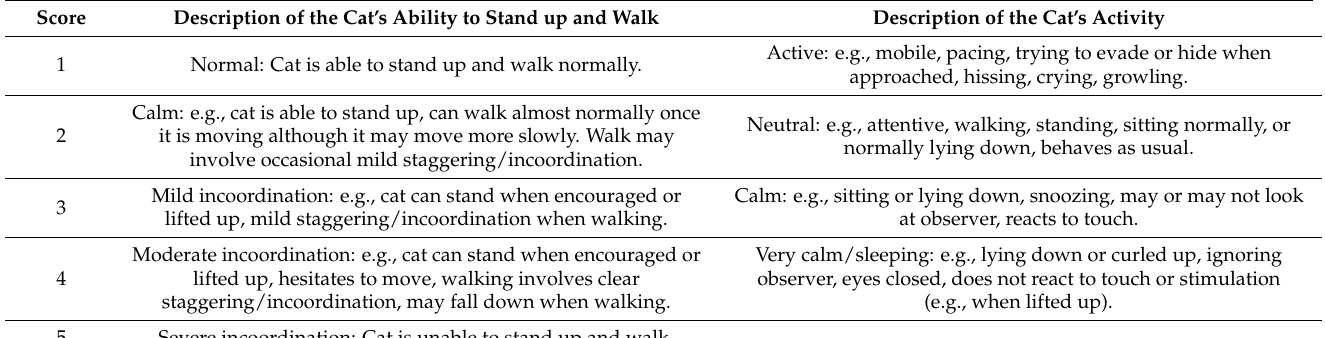
Table 6. Numerical rating scale for the owner’s assessment of the cat’s activity, and ability to stand up and walk. Modified from Korpivaara et al. (2017) [19] and Korpivaara et al. (2022)